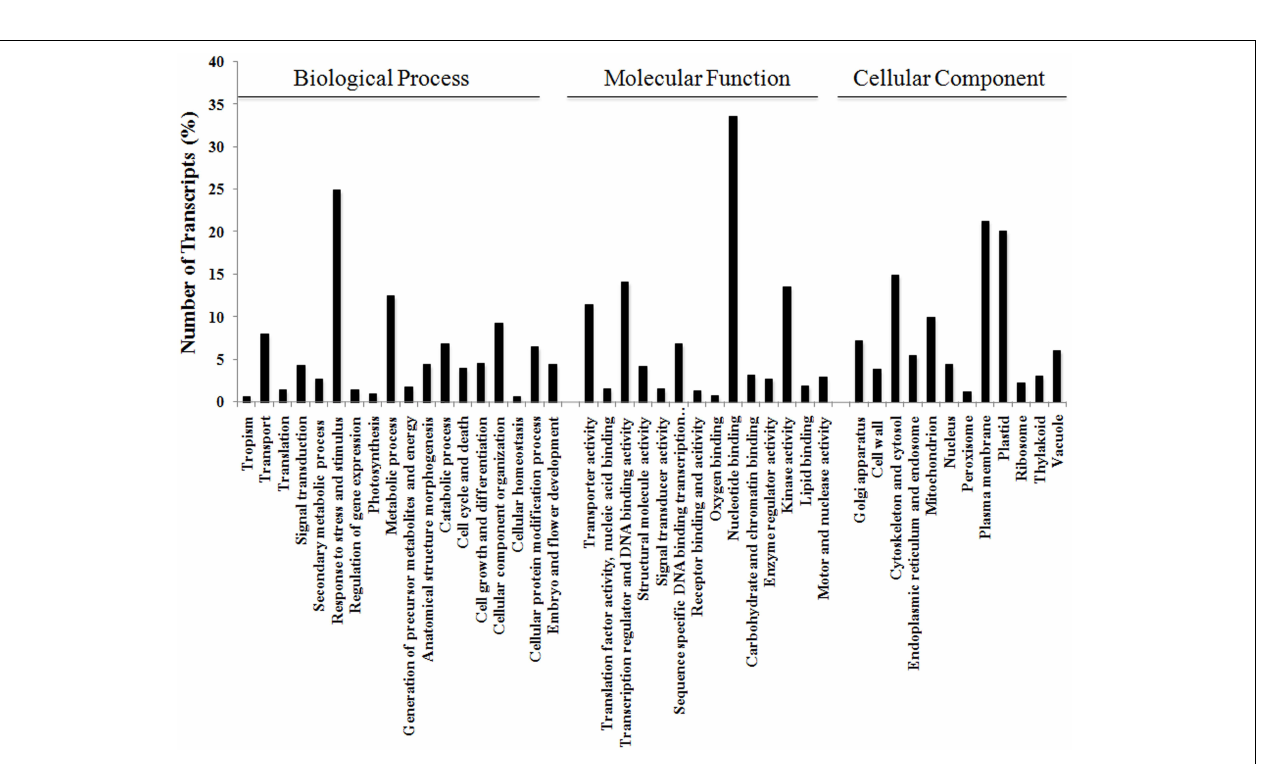
Frontiers in Plant Science |